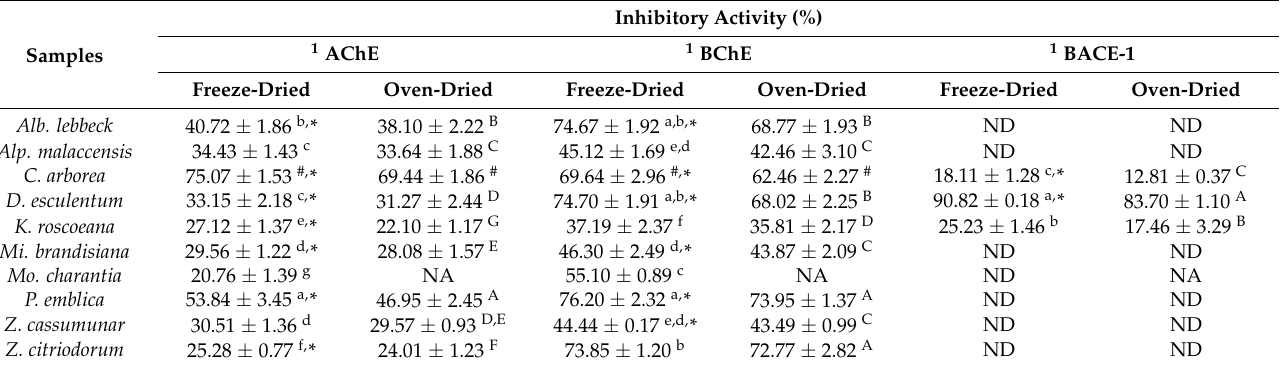
Table 5. In vitro inhibitory activities of 10 indigenous plant extracts prepared from freeze- and oven-drying processes against the key enzymes relevant to Alzheimer’s disease: acetylcholinesterase (AChE), butyrylcholinesterase (BChE), and β –secretase (BACE–1).